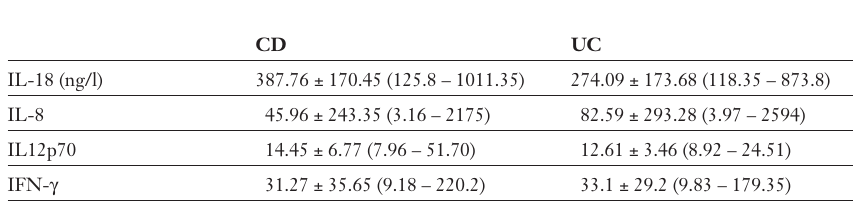
Laboratory results (mean, std, range) in patients with Crohn’s disease (CD; n = 81) and ulcerative colitis (UC; n = 43).